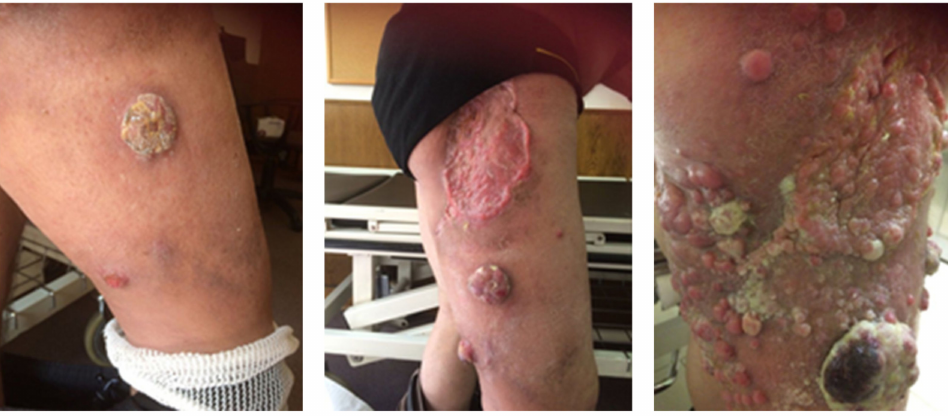
Figure 11. Progressive MCC despite of few lines of systemic therapies, inluding